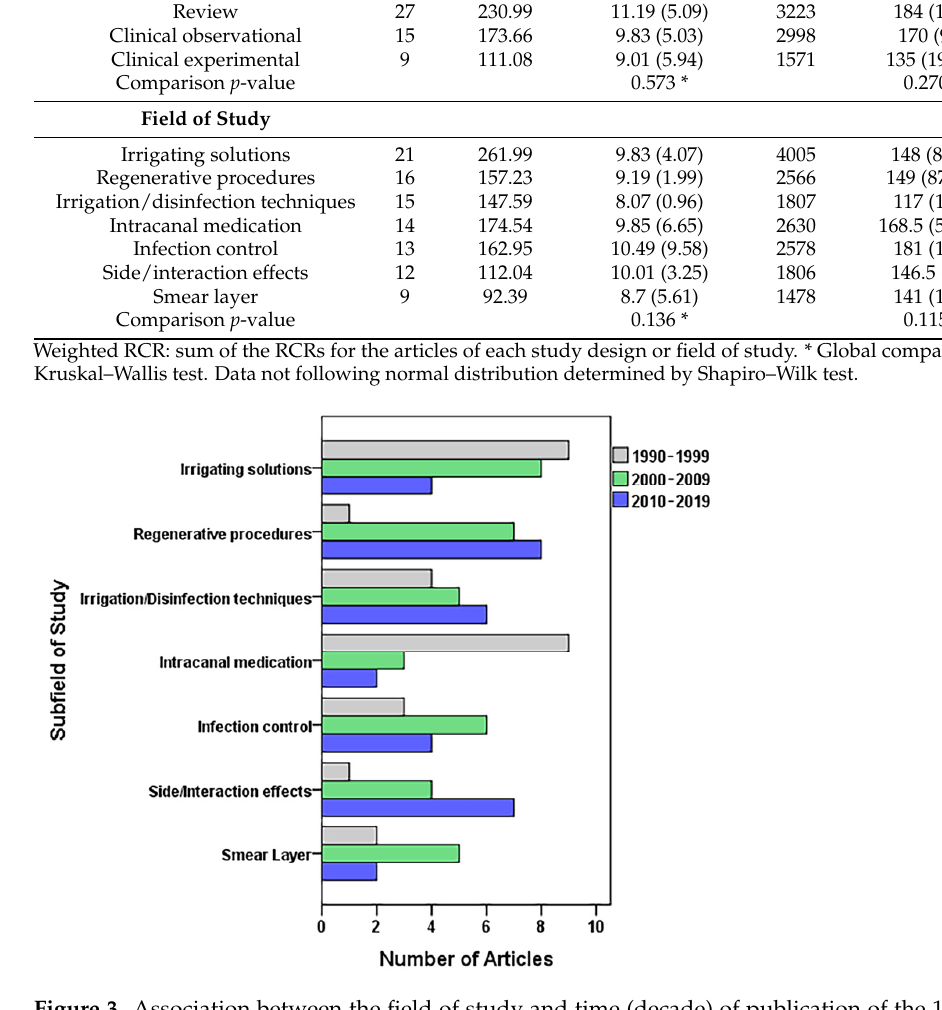
Figure 3. Association between the field of study and time (decade) of publication of the 100 root canal disinfection articles with the highest relative citation rates.